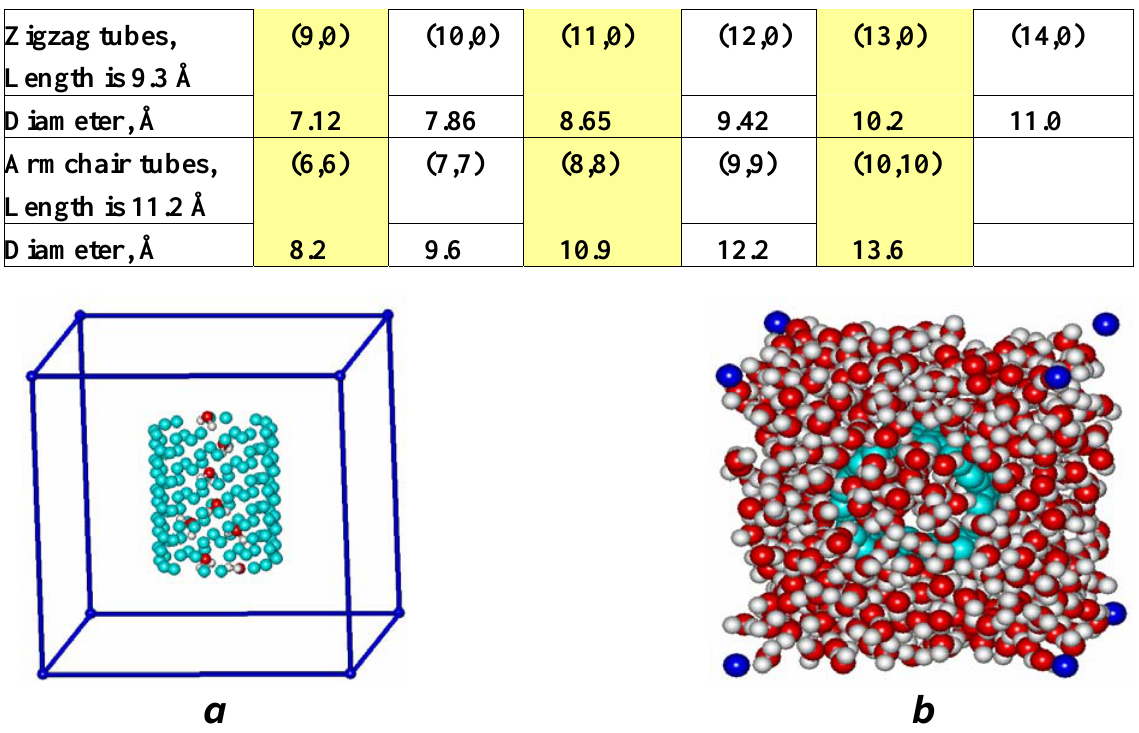
Figure 2. Elementary cell containing hydrated (8,8) carbon nanotube ( a ), the same without outer water shells ( b